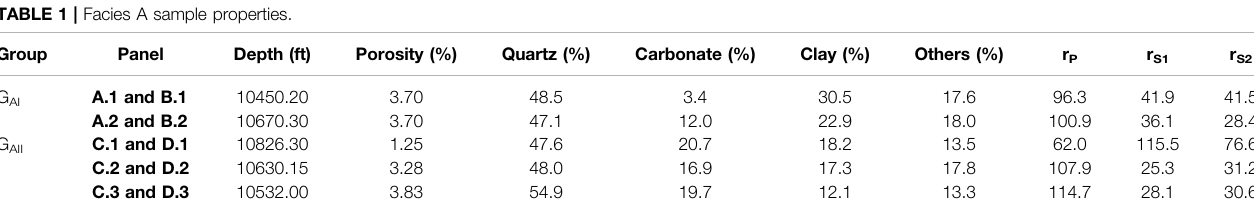
TABLE 1 | Facies A sample properties.